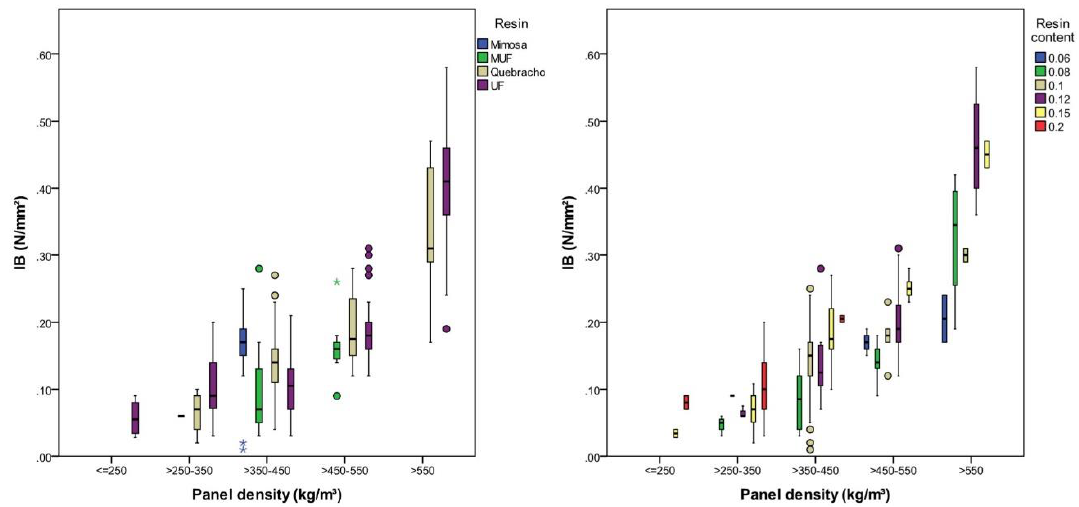
Figure 3. IB according to panel density, resin type and resin content. Table 4. IB of panels with varying resin types and contents.